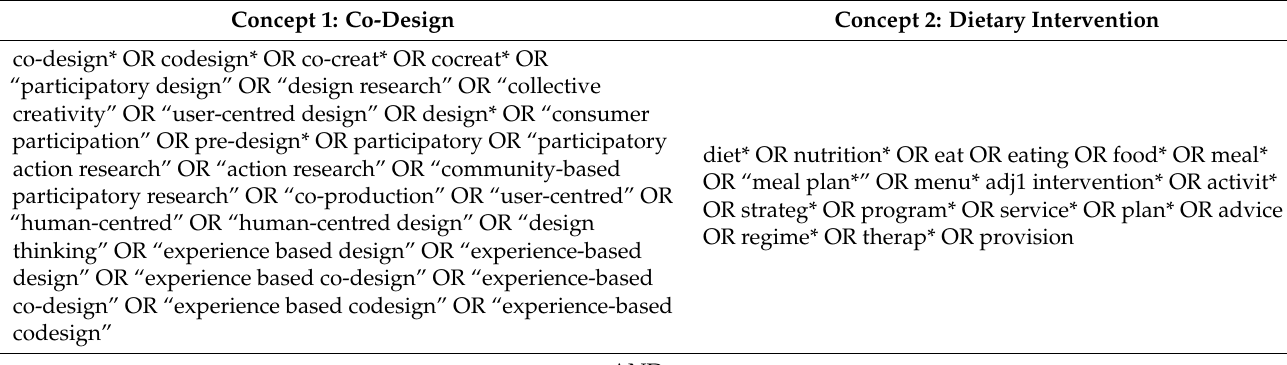
Table 2. Search concepts and synonyms included in